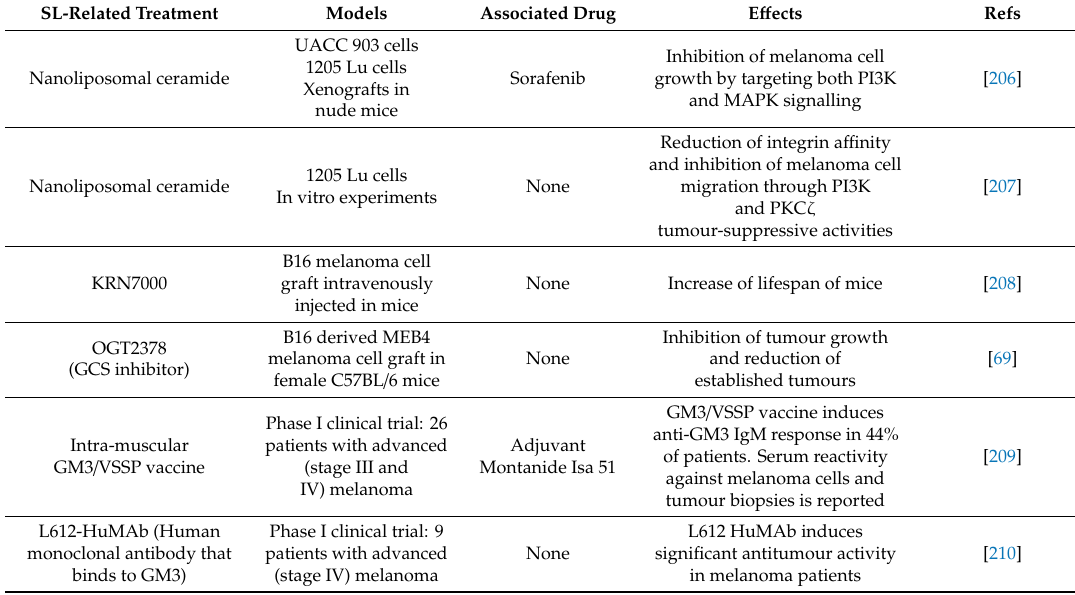
Table 3. SL-related molecules used therapy in